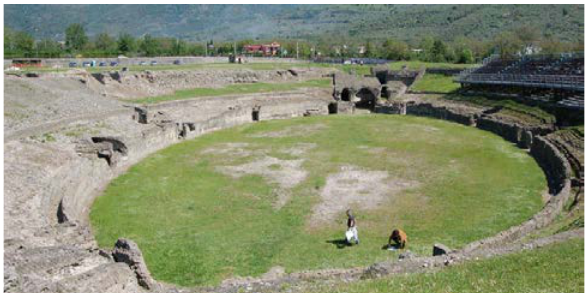
Figure 1: The Amphitheatre of Avella (Italy).